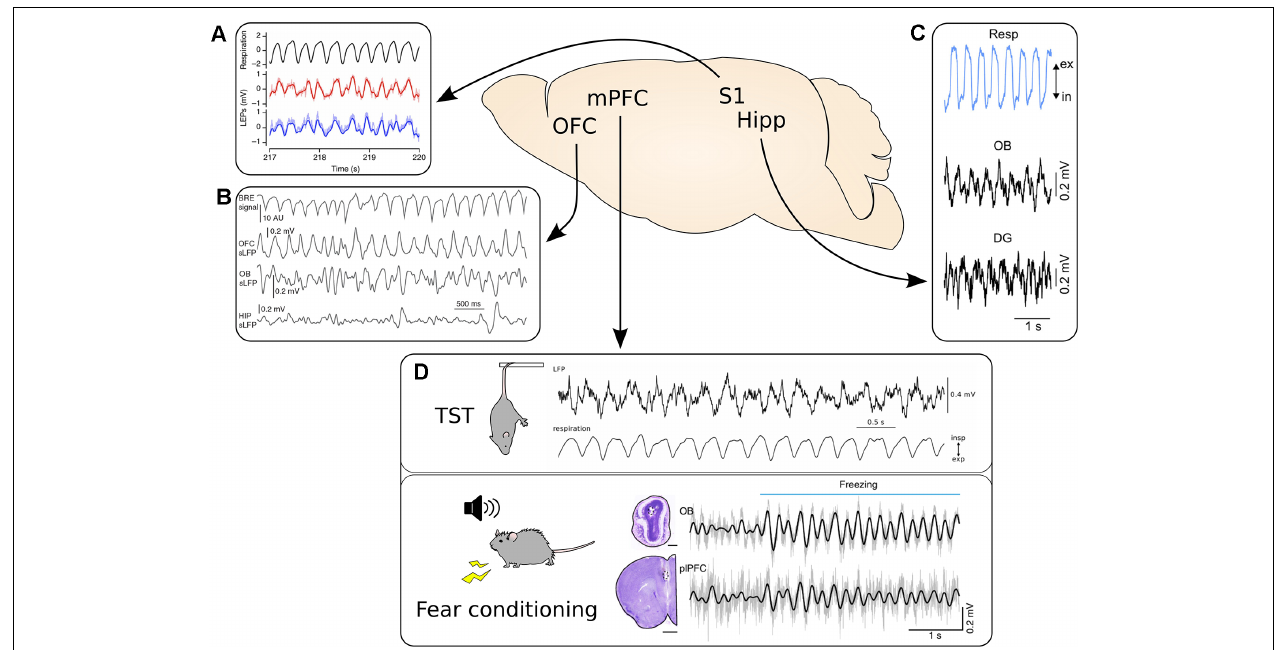
FIGURE 1 | Respiration-driven slow oscillations are widespread in the cortex. (A) Top, black: respiratory trace measured with a thermistor. Bottom, red/blue: LFP traces from two recording sites located 300 µ m apart in the whisker barrel cortex during accelerated breathing induced by exposure to hypoxic air. Reprinted from Ito et al. (2014) under CC BY 4.0. (B) Video-based measuring of breathing (BRE signal, top) and simultaneous LFP recordings from OFC, OB, and hippocampus (HIP) during immobility. Reprinted from K˝oszeghy et al. (2018) under CC BY 4.0. (C) Top, blue: respiration trace measured with a thermocouple. Middle and bottom, black: simultaneous LFP recordings from the OB and dentate gyrus (DG) of the hippocampus. Reprinted from Nguyen Chi et al. (2016) under CC BY 4.0. (D) The mPFC shows strong entrainment by respiration across a variety of behavioral states. Top: mPFC LFP recorded during immobility during the tail suspension test. Bottom: The simultaneous respiratory trace measured with a thermocouple. Adapted from Biskamp et al. (2017) under CC BY 4.0. Bottom: Synchronous LFP signal from the OB and prelimbic cortex (plPFC) recorded during auditory fear conditioning. Please note the increase in the amplitude of the 4 Hz rhythm in both LFP signals at freezing onset, indicated by the horizontal blue bar. Adapted from Moberly et al. (2018) under CC BY 4.0. ∗ p <